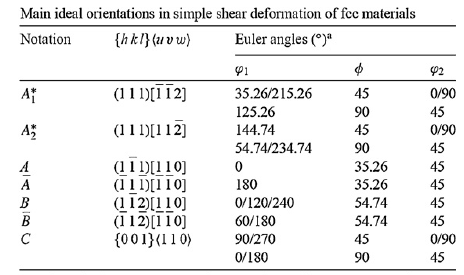
Table 2. Grain size and grain boundary statistics for FSP samples subjected to artificial aging. Aging Temperature.